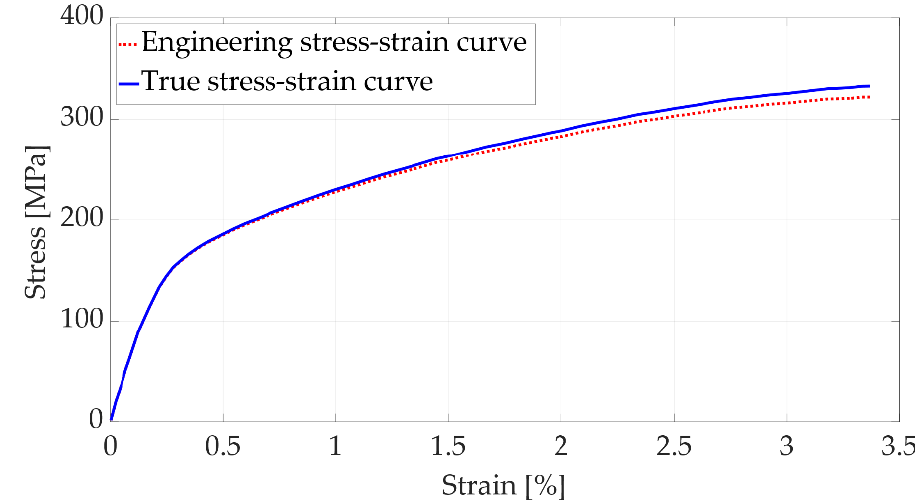
Figure 6. Stress–strain response of the SLM AlSi10Mg alloy.